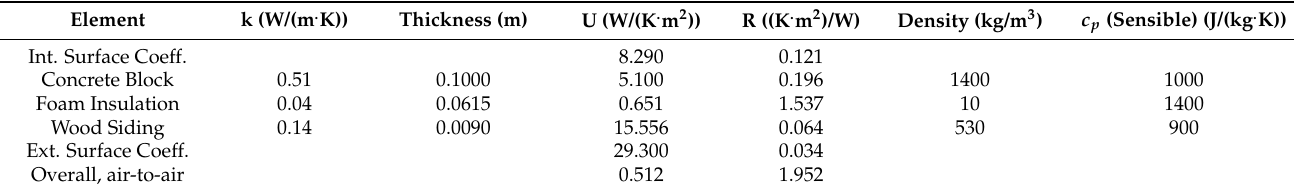
Table 1. Wall characteristics of the BESTEST 900 [31].